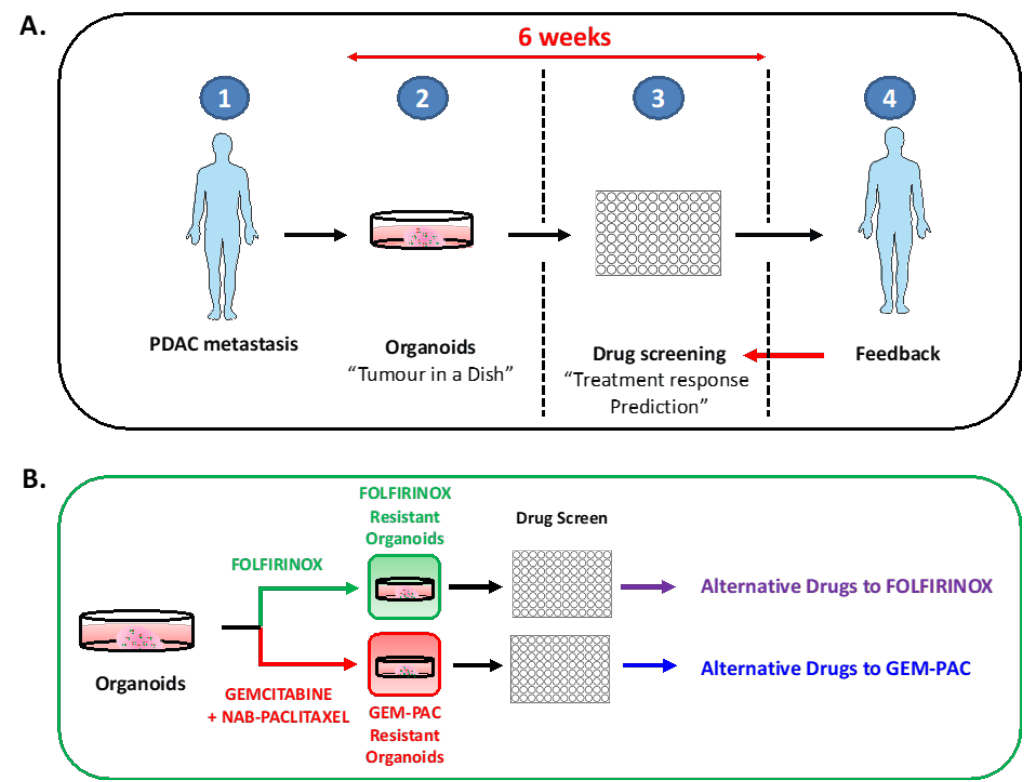
Figure 4. Scheme of “real-time” drug testing in metastatic PDAC and anticipation of drug resistance. ( A ) Organoids are isolated from liver metastasis (1–2) and expanded for 4 to 6 weeks prior performing the drug screen (3). The result is compared with the response of the patient and the treatment can be modified according to the drug sensitivity profile (4). ( B ) Anticipation of the resistance to the first-line therapy: Gemcitabine–paclitaxel and FOLFIRINOX using organoids. Creative Commons